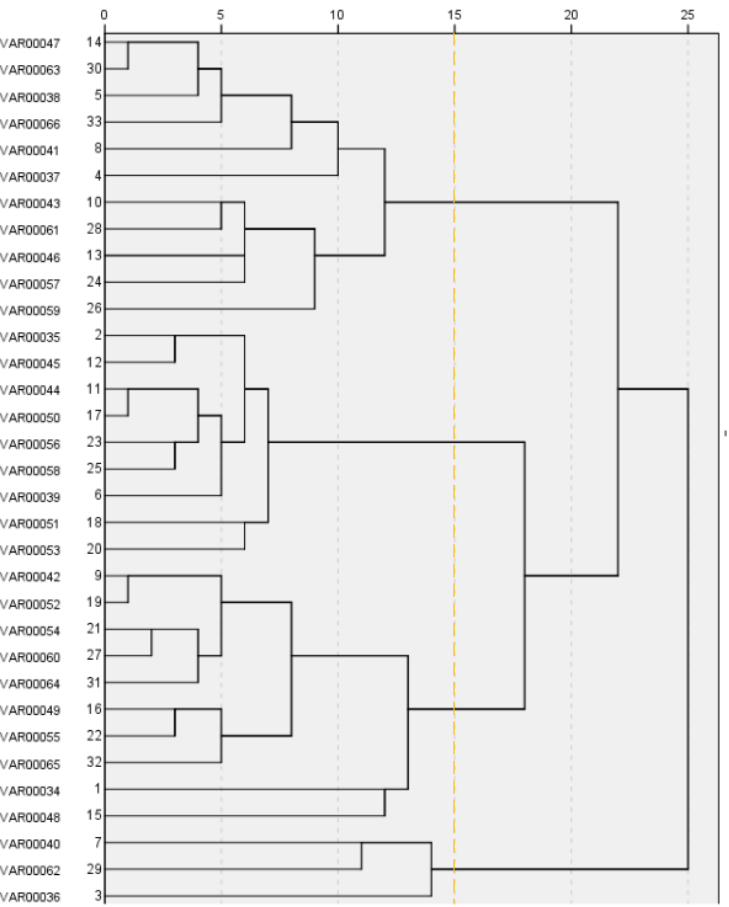
Figure 6. Cluster tree diagram.